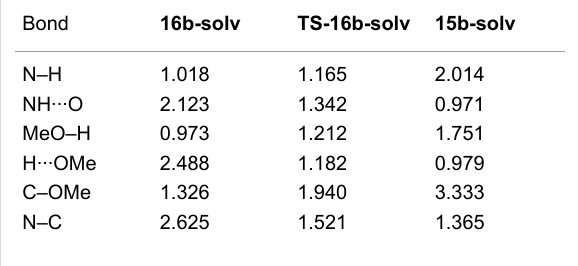
Table 4: Selected bond distances (Å) for the structures optimized along the transformation 16b-solv → 15b-solv